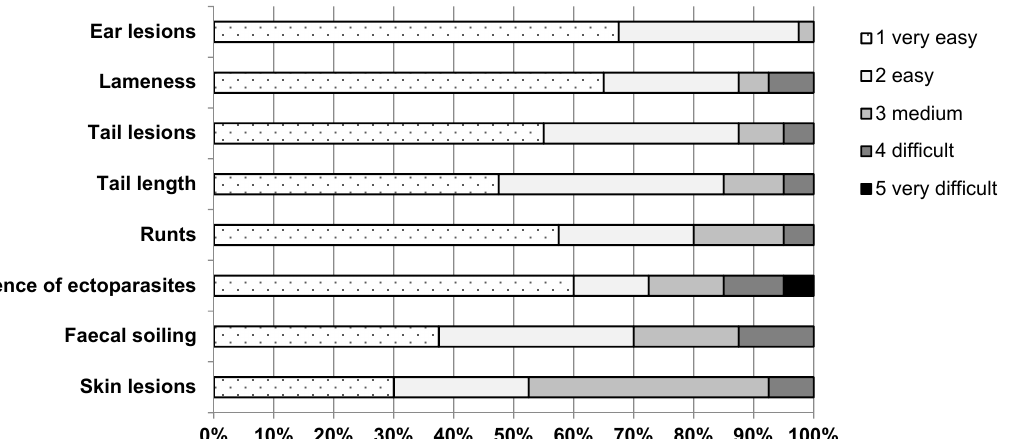
Figure 2. Assessment of the feasibility of the eight animal-based KTBL welfare indicators evaluated in individual animals on a five-point scale from very easy to very difficult according to the 40 fattening pig farmers interviewed in the present study (n = 40 ratings per indicator).